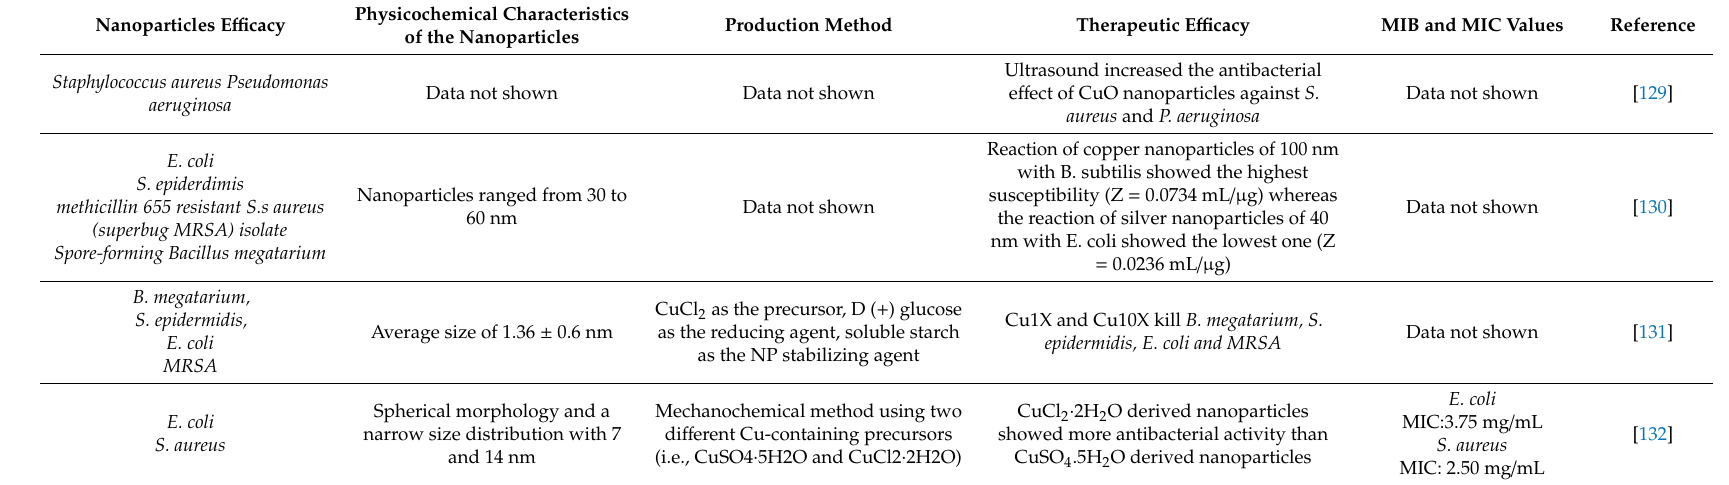
Table 3. Antibacterial applications of Cu and CuO-based nanoparticles, with respective minimum inhibitory concentration (MIC) and minimum bactericidal concentration (MBC)